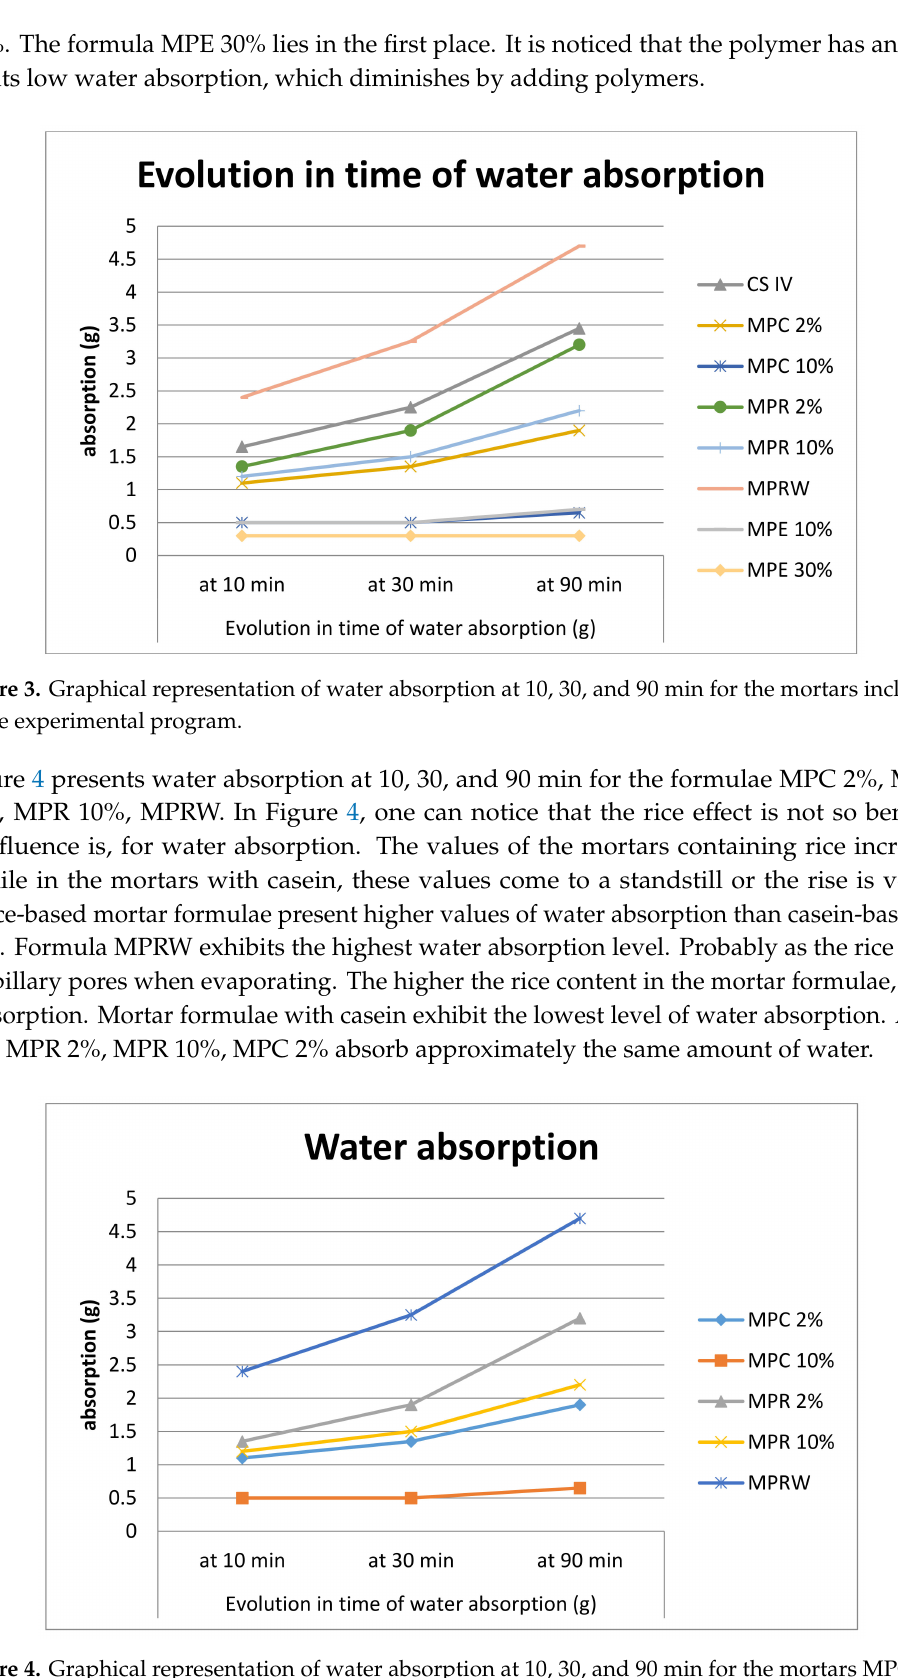
Figure 4. Graphical representation of water absorption at 10, 30, and 90 min for the mortars MPC 2%, MPC 10%, MPR 2%, MPR 10%,